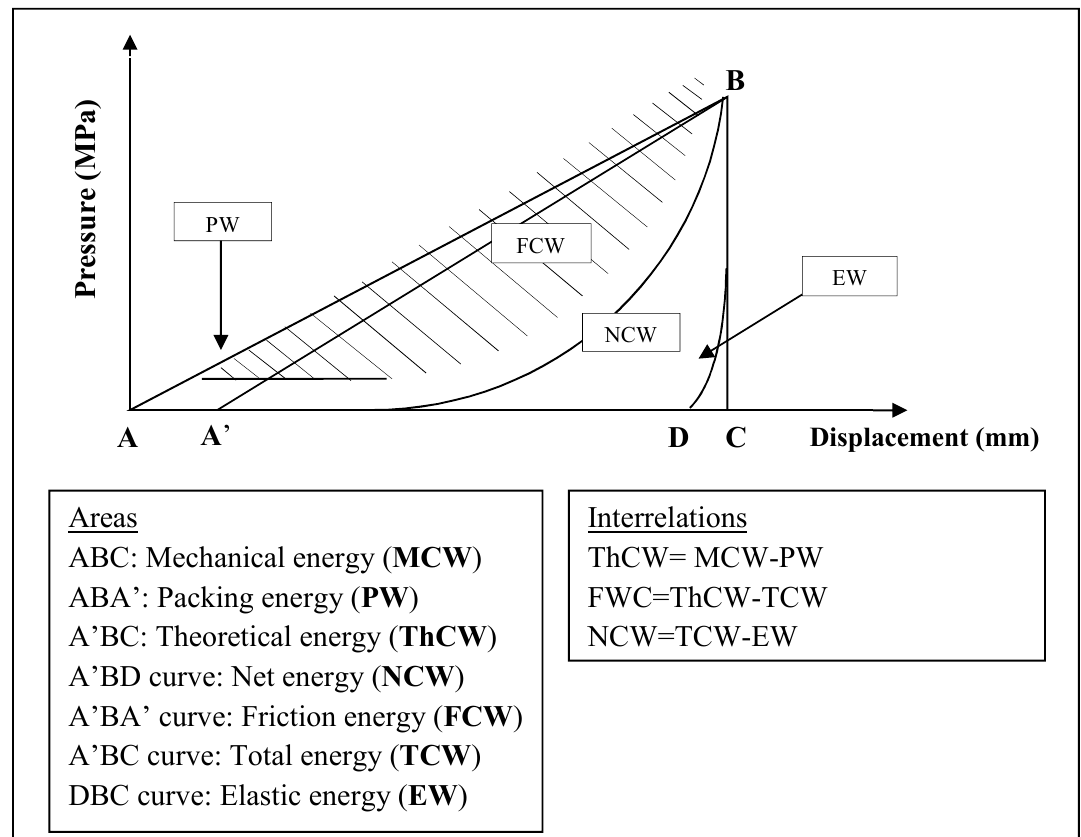
Figure 3. Schema of the compression cycle and the associated energies.